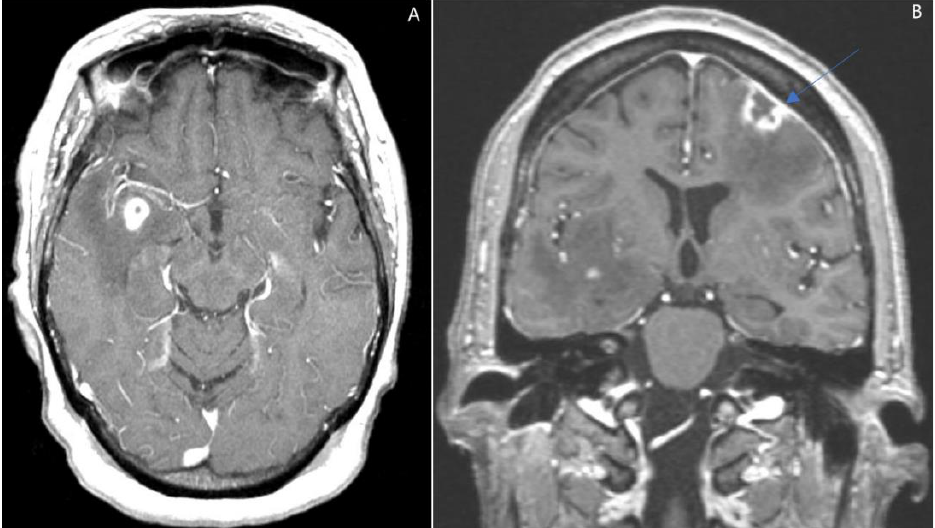
Figure 4. ( A,B ) Axial and Coronal enhanced T1 weighted MRI. There are peripherally enhancing lesions within the left frontal and right temporal lobes and pachymeningeal enhancement (blue arrow, B ) overlying the left frontal lesion.